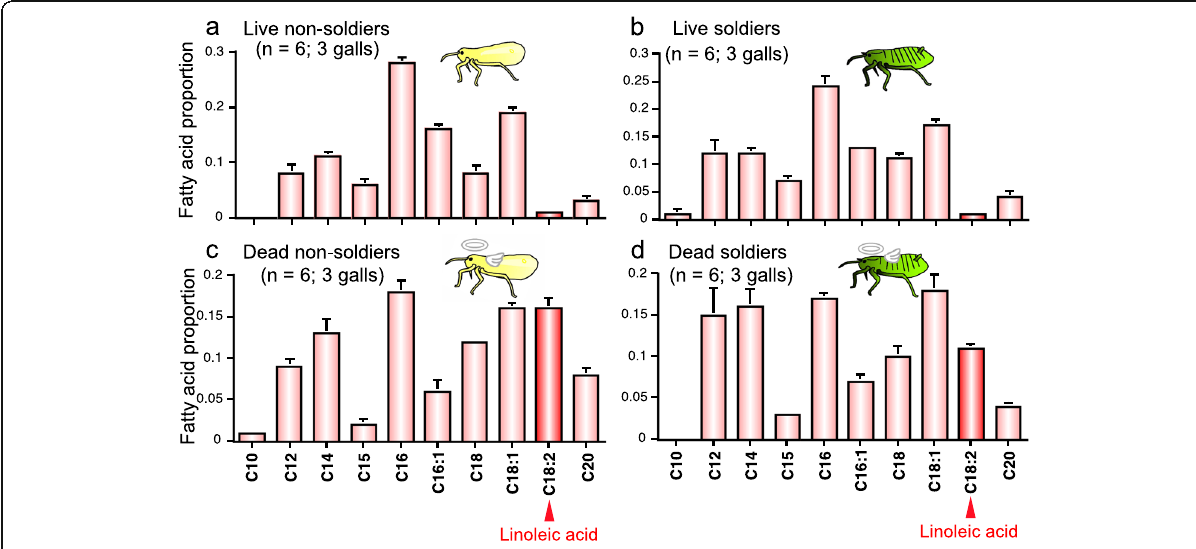
Fig. 3 Relative quantities of fatty acids on the body surface of T. styraci . ( a ) Live old adults. ( b ) Live old soldiers. ( c ) Dead old adults 3 to 7 days after freeze-killing. ( d ). Dead old soldiers 3 days or longer after freeze-killing. Statistically significant differences were detected in linoleic acid proportion between the live and dead adults (Wilcoxon rank-sum test; P < 0.05) and between the live and dead soldiers (Wilcoxon rank-sum test; P < 0.005). Sample sizes are shown in parentheses and standard errors are shown by vertical